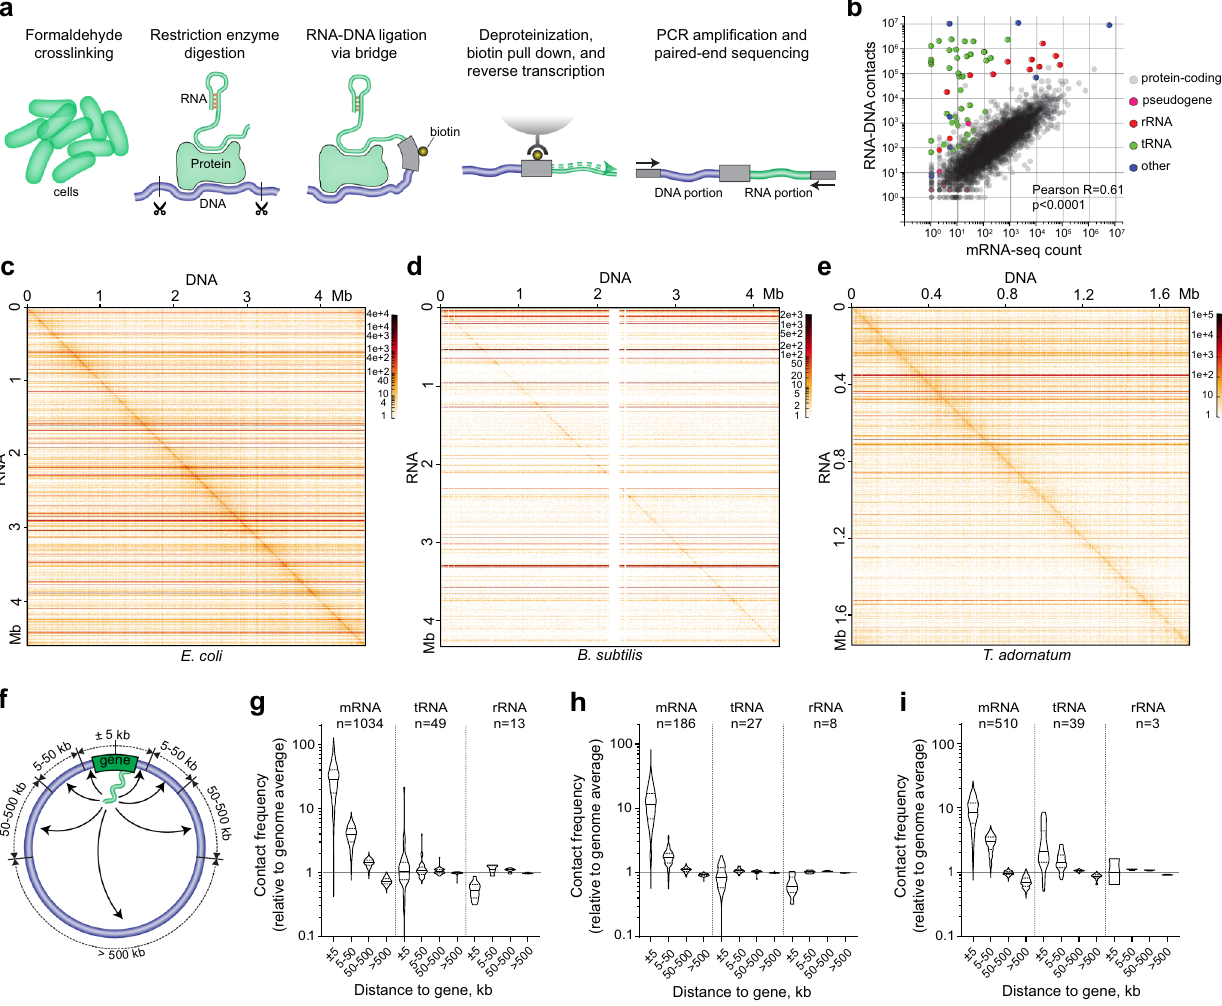
Fig. 1 RNA – DNA interactomes of E. coli , B. subtilis , and T. adornatum identi fi ed by RedC. a Schematic of RedC protocol. b Correlation betweenthe number ofRNA – DNA contacts and mRNA-seqsignal for E. coli . Pearson correlation coef fi cient wascalculated for mRNAs. c – e Whole-genome RNA – DNAcontactmaps for E. coli ( c ), B. subtilis ( d ), and T. adornatum ( e ). f Scheme showing analyzed genomic intervals. g – i Frequency of contacts of mRNAs, tRNAs, and rRNAs in indicated genomic intervals relative to the average contact frequency of respective RNAs in the genome for E. coli ( g ), B. subtilis ( h ), and T. adornatum ( i